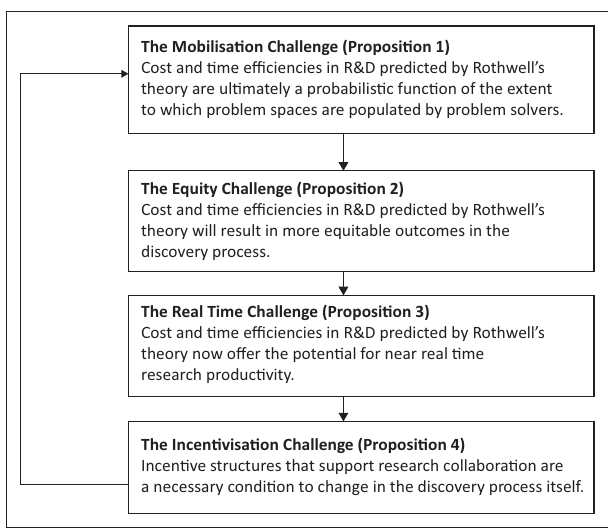
FIG URE 2: Rothwell’s augmented theory: Key societal